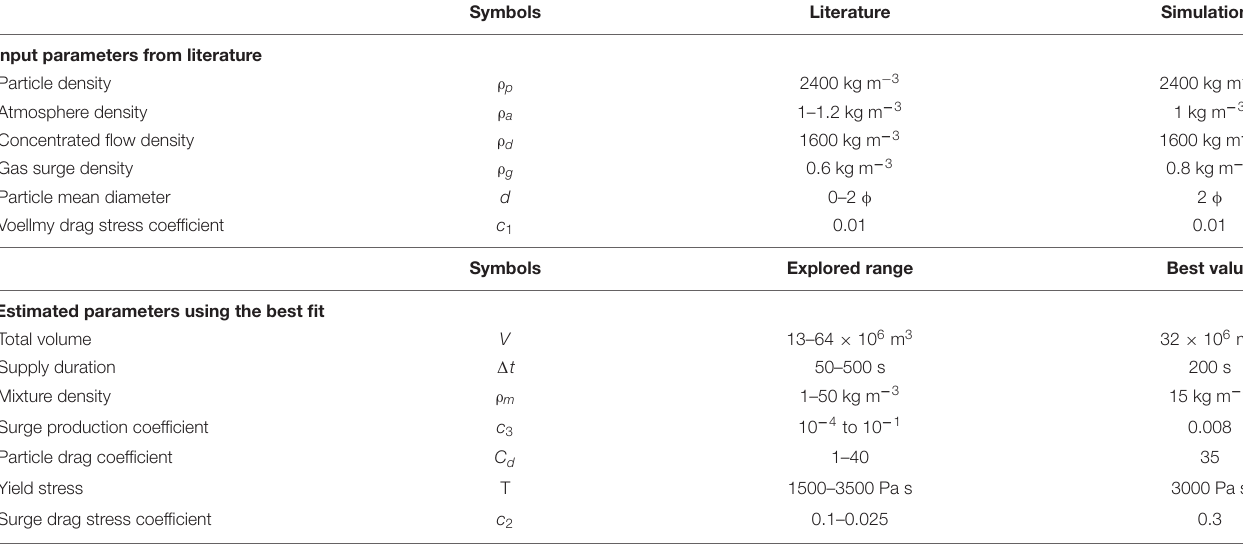
TABLE 2 | Input parameters for the best-fit VolcFlow simulation presented in Figure 7